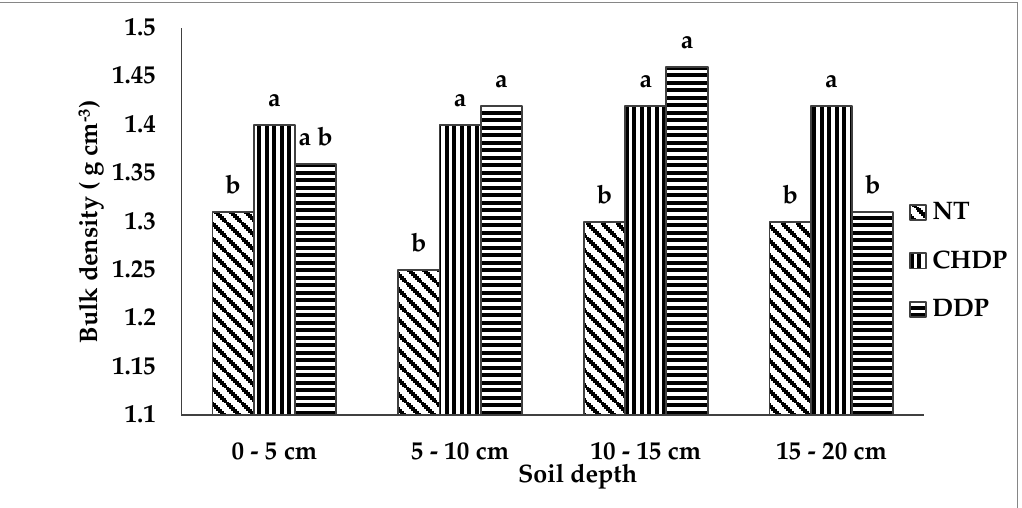
Figure 8. Bulk density in the soil profile at intervals of 5 cm after three years of the tillage treatments in 2016. Means values with the same letter in the same depth interval are not significantly different (Tukey, α ≤ 0.05).